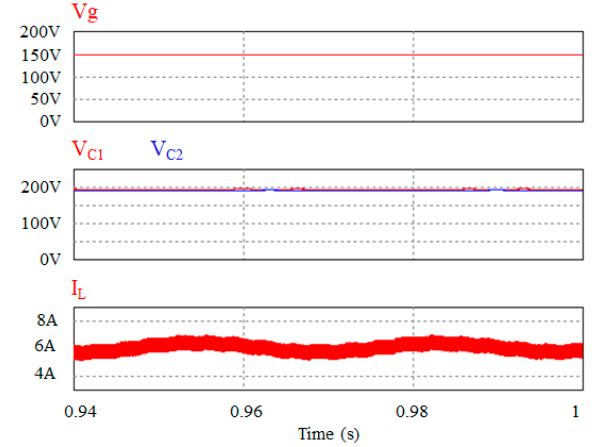
Figure 5. Simulation results of DC input voltage ( V g ), capacitor voltages ( V C1 and V C2 ), and inductor current ( I L ) of the proposed method.